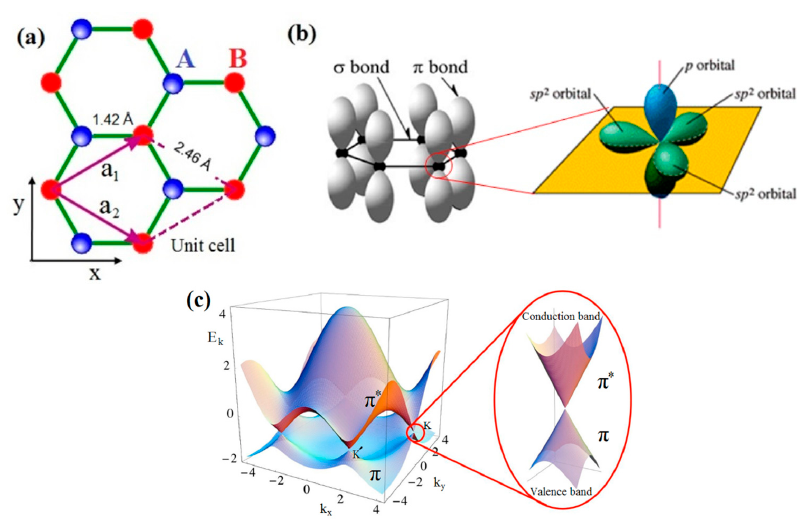
Figure 2. ( a ) Bravais lattice of the graphene; ( b ) σ and π bonds in graphene; ( c ) graphene π - and π *-band structure [12].